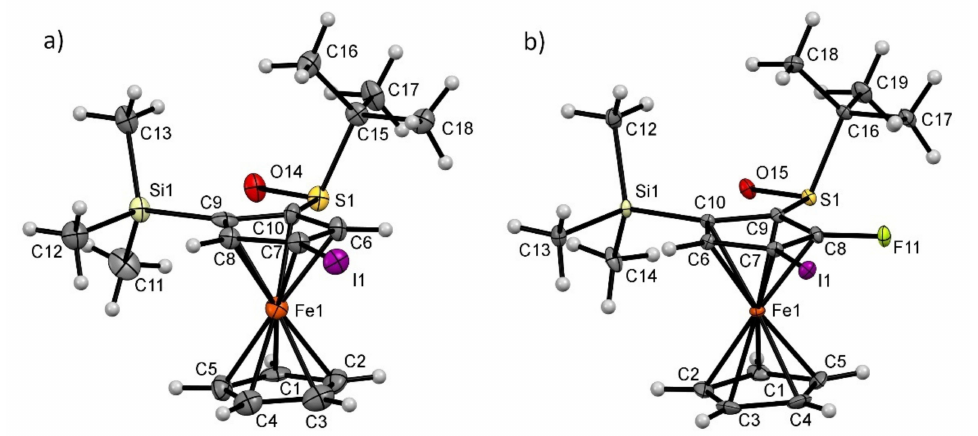
Figure 5. Molecular structure of the compounds ( a ) S , S P -7 and ( b ) S , S P -9b at the solid state. Thermal ellipsoids shown at the 30% probability level. Selected bond lengths [Å] and angles [ ◦ ] for S , S P - 7 : C10-S1 = 1.770(1), C9-Si1 = 1.890(1), C7-I1 = 2.090(1), O14-S1-C10-C9 = 4.18, I1 ··· O14 = 2.926, S1-O15 ··· I1 = 116.72, O15 ··· I1-C7 = 172.48. Selected bond lengths [Å] and angles [ ◦ ] for S , S P -9b : C9-S1 = 1.790(4), C10-Si1 = 1.893(5), C7-I1 = 2.090(5), C8-F11 = 1.349(5), O15-S1-C9-C10 = 1.36,